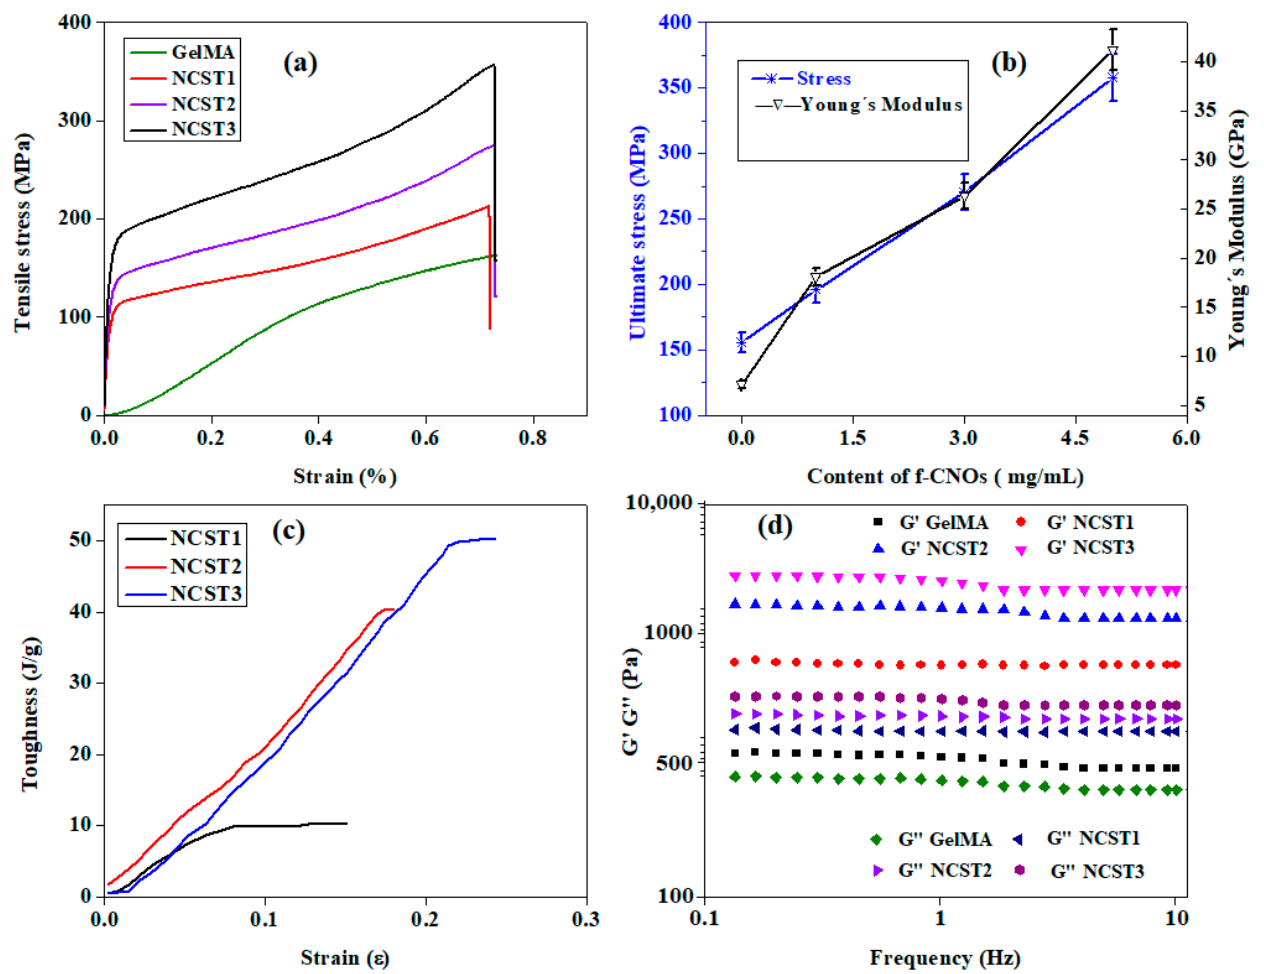
Figure 4. The curves illustrating the mechanical properties of hydrogels: ( a ) tensile stress, ( b ) tensile strain vs. Young’s modulus, ( c ) toughness, and ( d ) storage and loss modulus (G’ G’’).